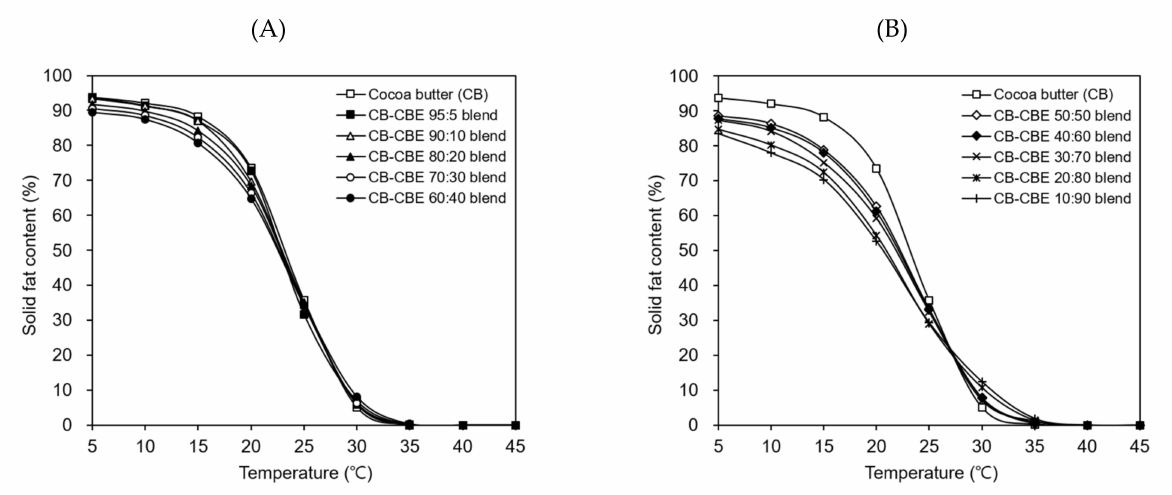
Figure 7. Solid-fat content of cocoa butter and cocoa butter–cocoa butter equivalent (CBE) blends with the cocoa butter:CBE weight ratios ranging from 95:5 to 60:40 ( A ) and from 50:50 to 10:90 ( B